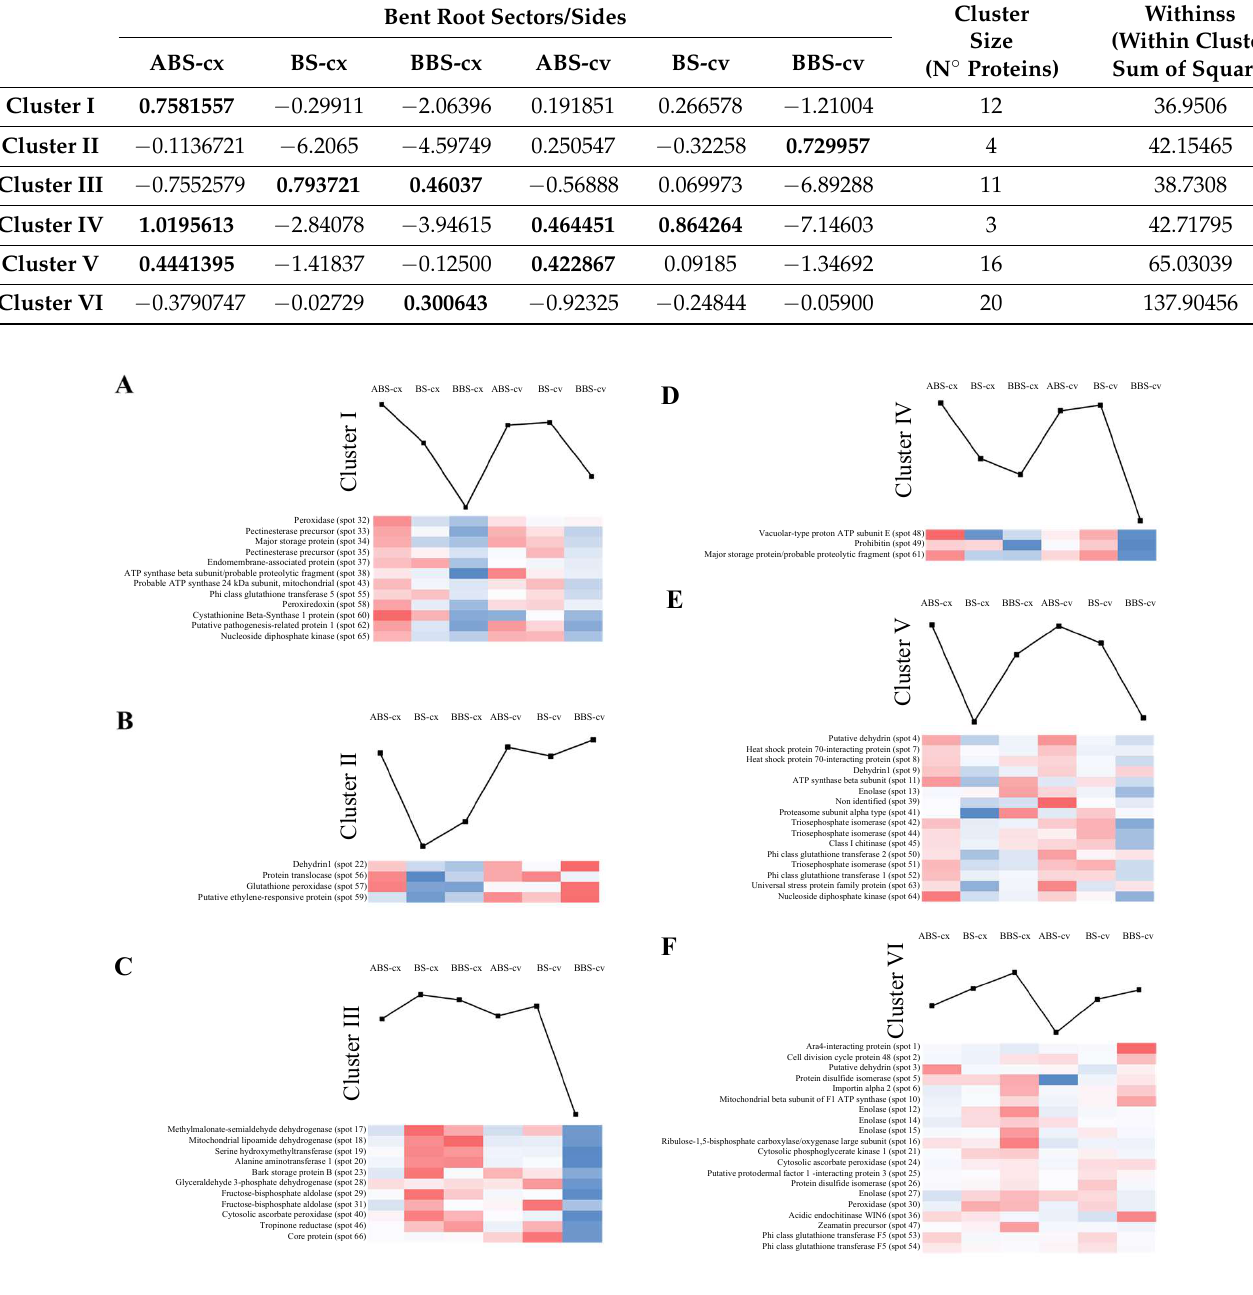
Figure 2. Cluster analysis on protein abundance profiles (PAPs). Subfigures ( A – F ), corresponding with the six clusters (I–VI) show the distribution heatmaps of the 66 differentially represented protein spots according to their PAP (k-means analysis). Line charts show the average of PAPs calculated as the mean value of all cluster-related proteins. ABS, above bending sector; BS, bending sector; BBS, below bending sector; cx, convex side; cv, concave